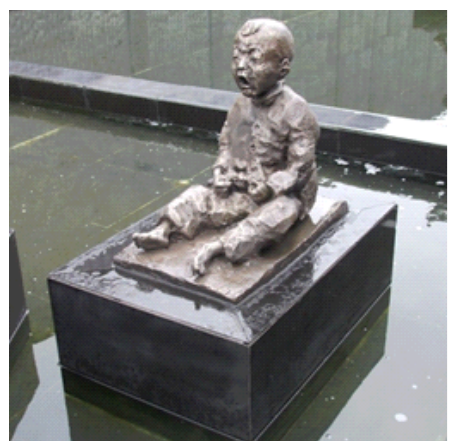
Figure 1. Baby Ping-Mei. Source: Karin